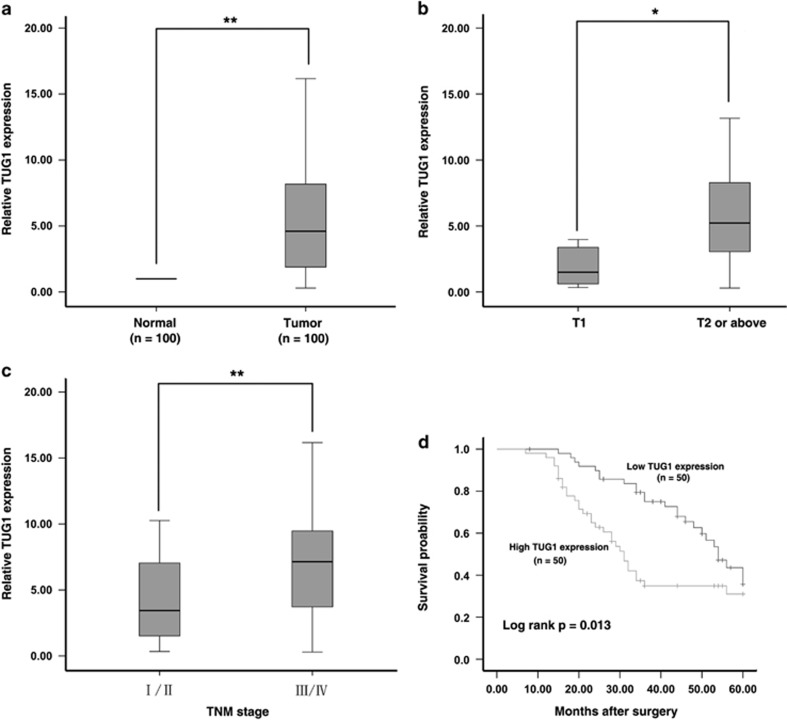
Expression of TUG1 in GC tissues and its clinical parameters. (a) Relative expression of TUG1 in GC tissues (N=100) compared with the corresponding non-tumor tissues (N=100). TUG1 expression was examined using quantitative real-time PCR (qRT-PCR) and normalized to β-actin expression. The results are presented as the fold-change in tumor tissues relative to normal tissues. (b and c) Higher TUG1 was positively correlated with advanced invasion depth and TNM stage. (d) Patients with high levels of TUG1 expression showed reduced survival times compared with patients with low levels of TUG1 expression. *P<0.05, **P<0.01